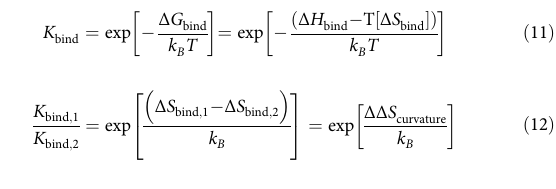
increase for simulated IDPs on vesicles in the 40 to 200 nm diameter